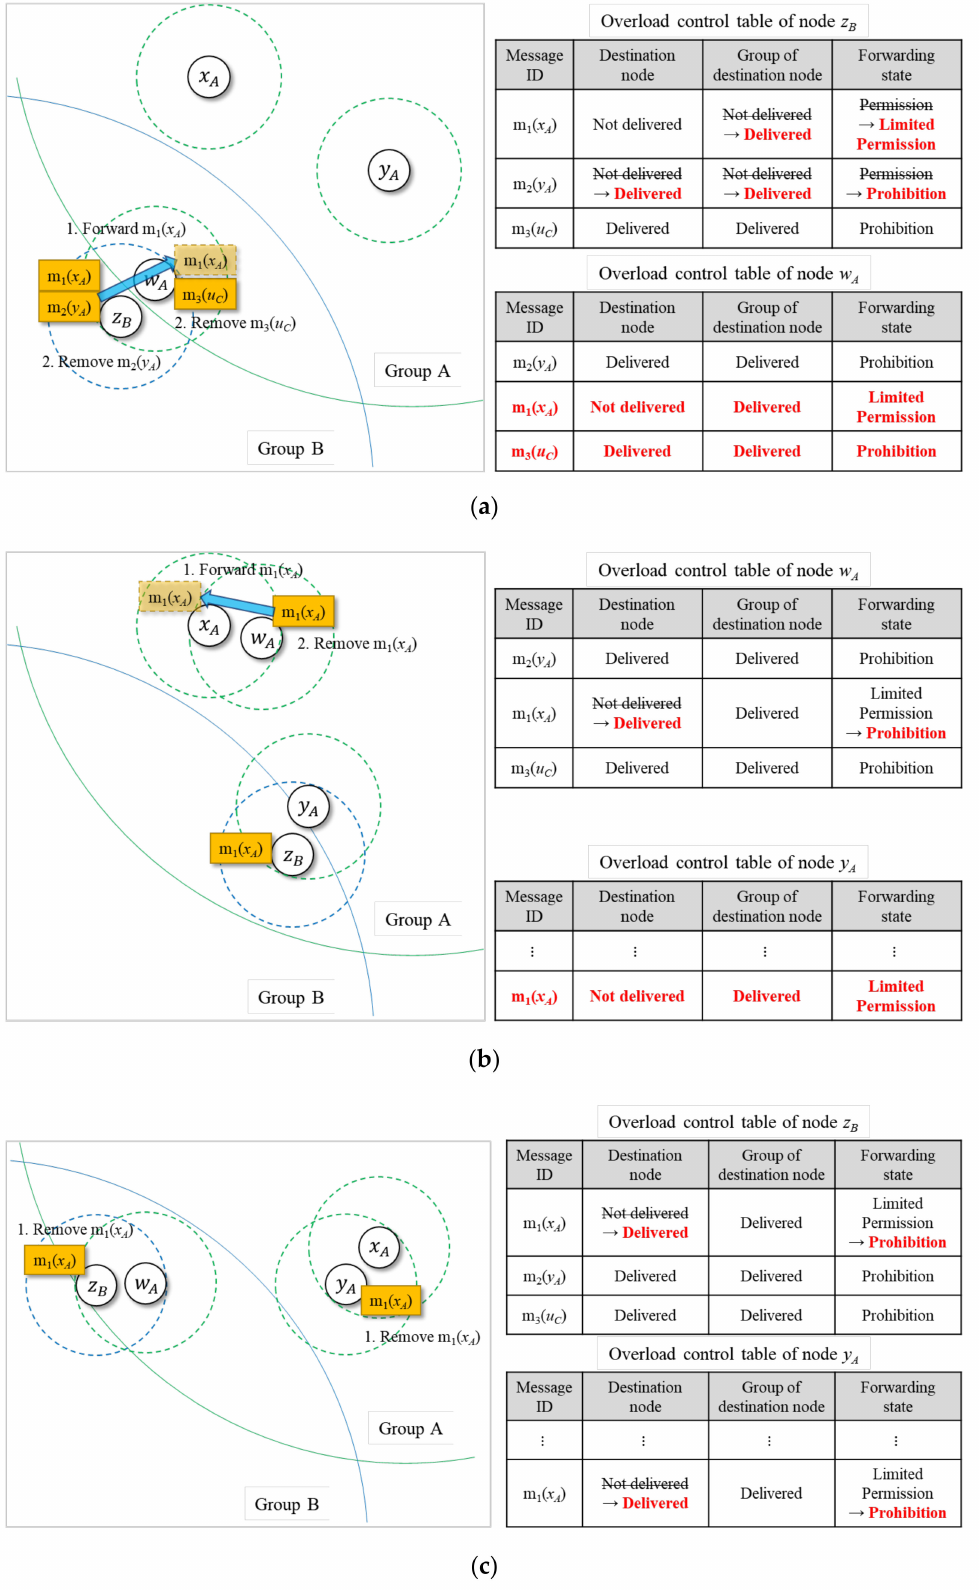
Figure 3. Examples of overload control table. ( a ) Overload control table of nodes z B and w A ; ( b ) Overload control table of nodes w A and y A ; ( c ) Overload control table of nodes z B and y A